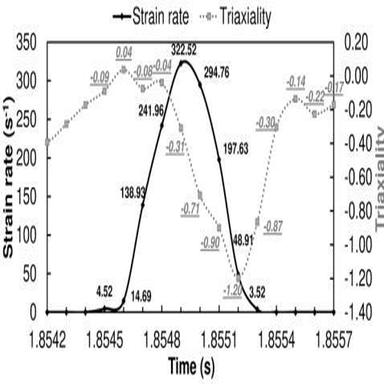
Evolution of strain rate and stress triaxiality within the mid-sensor during the roller cycle (roller passing over the sensor location) corresponding to point A shown in Fig. 6.